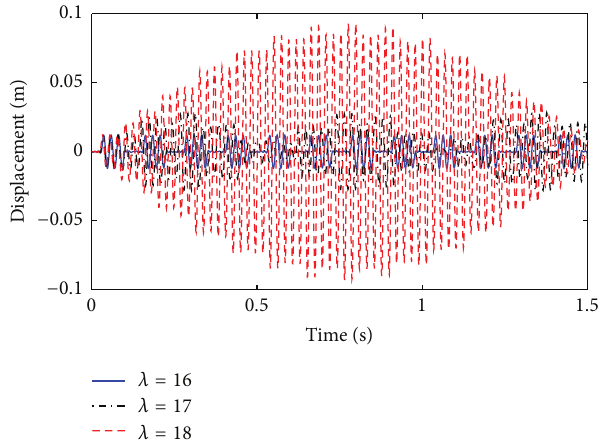
Figure 5: Vibrations imposed by boundary conditions with polyg- onal action at the end